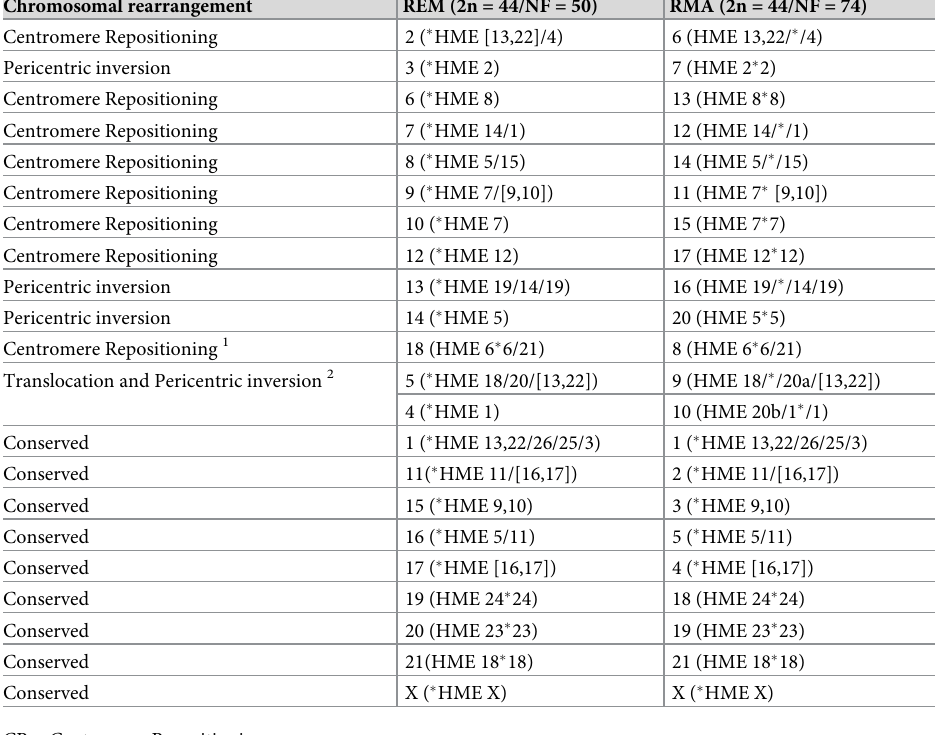
Table 4. Chromosomal rearrangements that differentiate the R . emiliae and R . mastacalis cytotypes, as identified by HME whole chromosome probes. Chromosomal